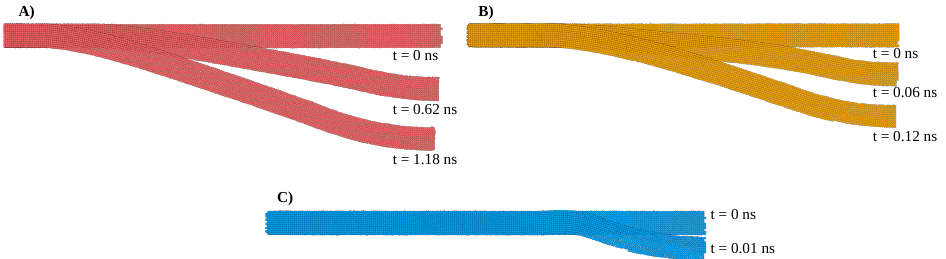
Figure 4. The snapshots of the workpiece deformation before the complete failure at different time. Different constant loading speeds: ( A ) A low speed of 0.1Å/ps, ( B ) a medium speed of 0.8Å/ps, and ( C ) a high speed of